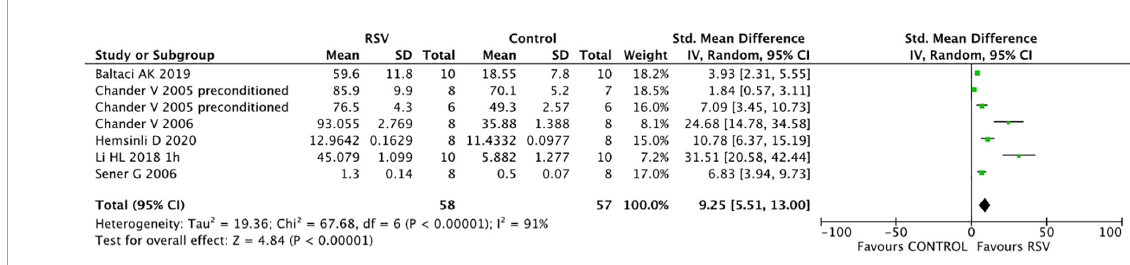
FIGURE5 Forest plot for the effects of resveratrol on glutathione.